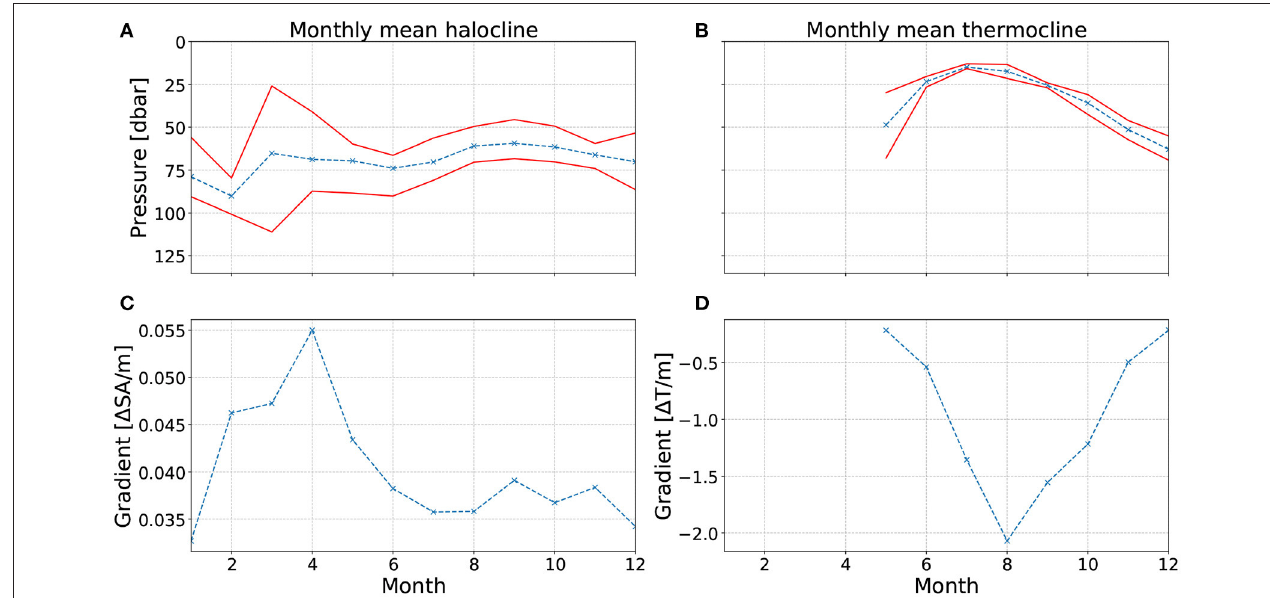
FIGURE 5 | Monthly means of (A) halocline and (B) thermocline depth and the strength of (C) salinity and (D) temperature gradients at the pycnocline depths calculated from Argo data. Means for months 1–4 include only 2015–2017 data due to lack of profiles and the other months include the entire dataset period of 2012–2017. The red lines in (A,B) show the maximum and minimum depths of halocline and thermocline for each